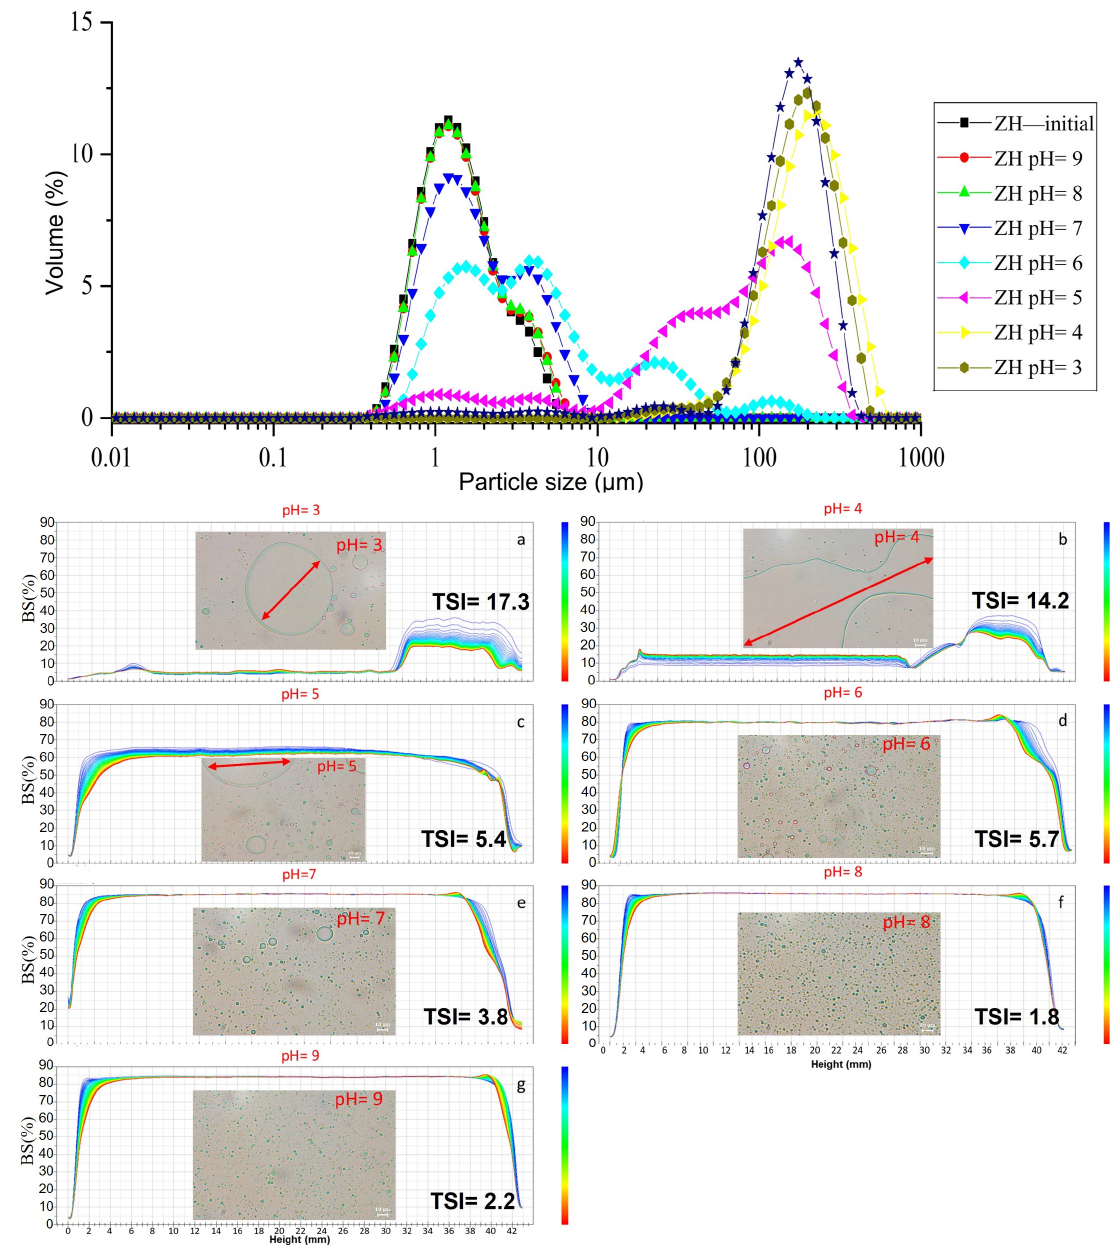
Figure 5. Particle size distribution of emulsions stabilized by ZH 0.6–70 at different pH ( a ); Back-scattered light map and microscopic images (scale bar = 10 µ m) of emulsions stabilized by ZH 0.6–70 at different pH ( b ).